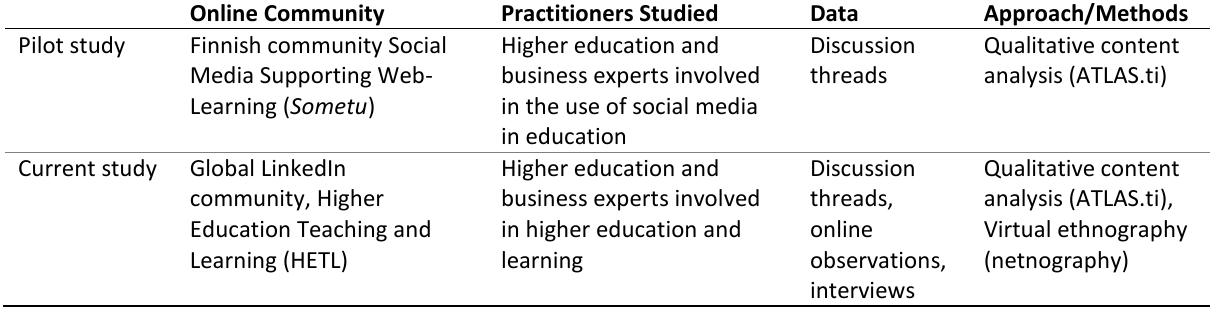
Table 1. Virtual communities of practice